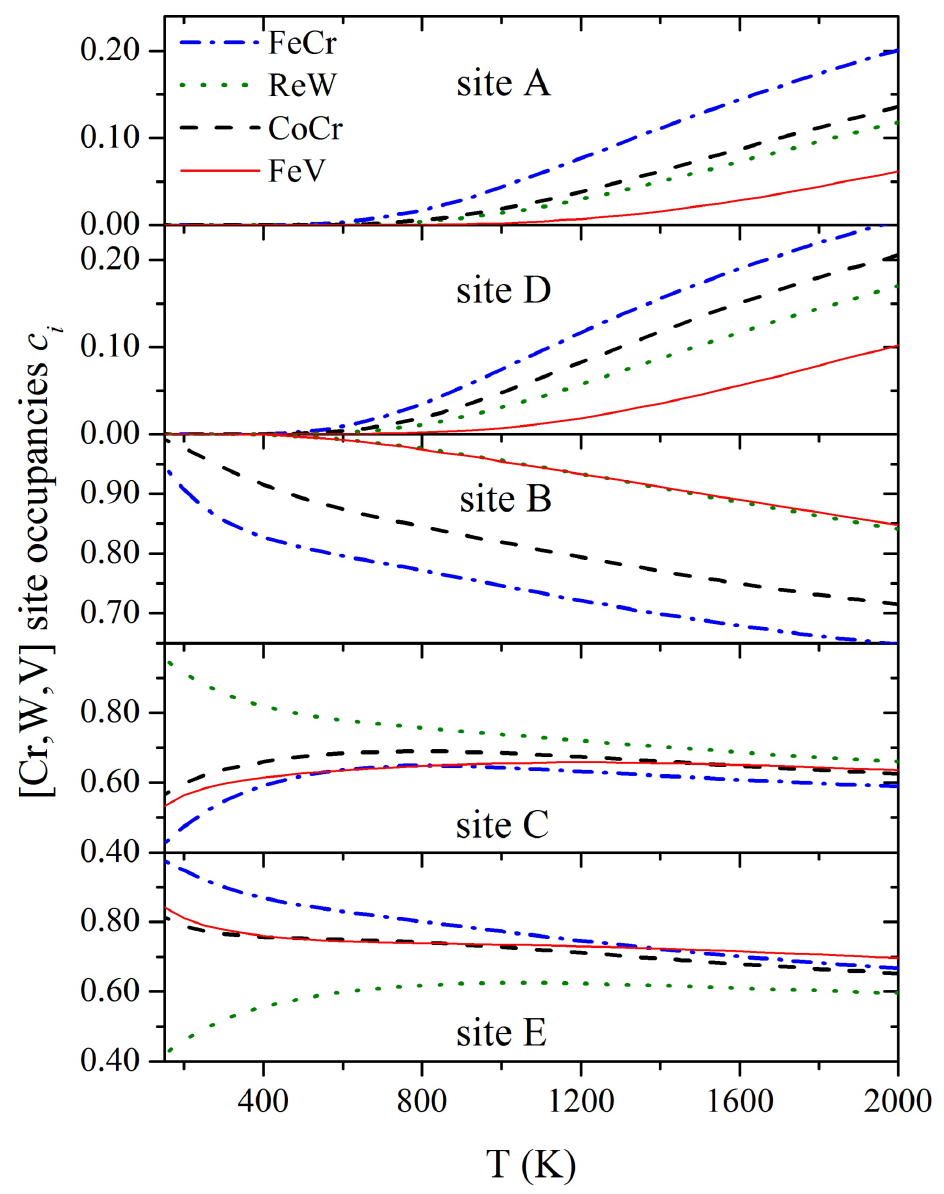
full composition range of the σ -phase formation. In Figure 4 the Cr site distribution calculated versus the alloy composition is displayed together with the experimental data from [29] measured at various temperatures. Taking into account the scattering of the experimental data, good agreement is found between the present calculated results and the experimental measurements (probabilities), justifying our theoretical model also for this case. Figure 3. The site occupancies of the (A, B, C, D, E) sublattices for the reference components in the Re W , Co Cr and Fe V alloys in comparison with the results 0 . 5 0 . 5 0 . 5 0 . 5 0 . 5 0 . 5 σ -phase from [14] (without temperature for the Fe Cr 0 . 5 0 . 5